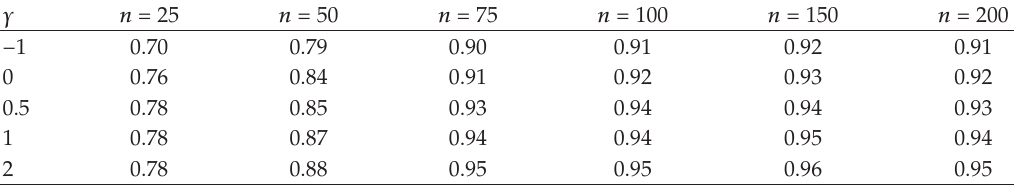
Table 8: Empirical coverage probabilities for the exponential distribution, B (cid:6) 1000.